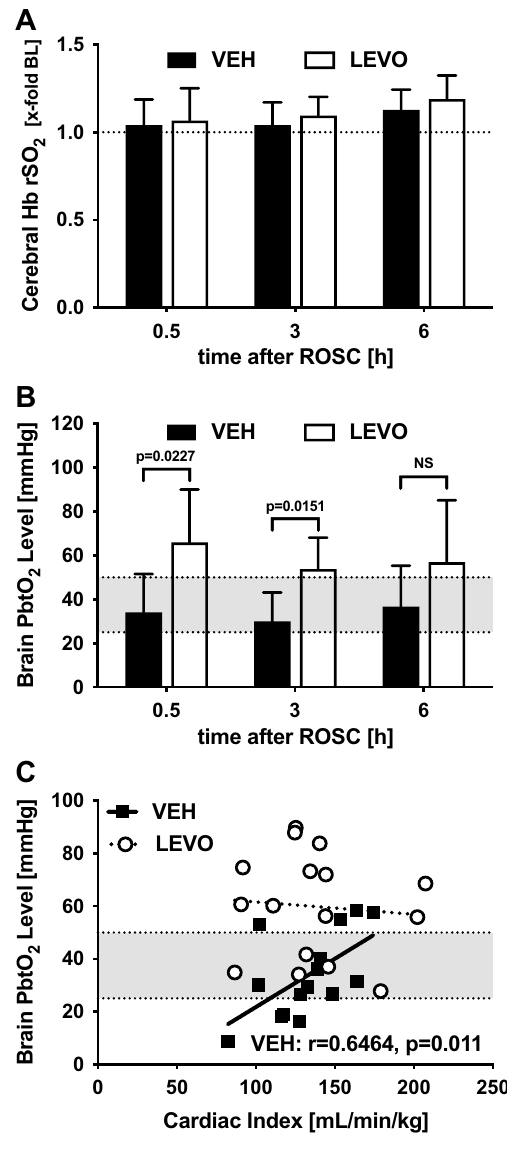
Figure 4. Cerebral tissue oxygenation. ( A ) Brain oxygenation was determined noninvasively by quantifying brain hemoglobin (Hb) oxygen saturation (rSO 2 ) before and 0.5, 3, and 6 h after ROSC. Because of high interindividual differences, readings were normalized to baseline. rSO 2 was not altered following cardiac arrest and did not differ between groups. VEH vehicle; LEVO levosimendan. Statistics: repeated measures two-way ANOVA, followed by Šidák’s multiple comparisons test; data are presented as means ± SD. ( B ) Brain tissue oxygen (PbtO 2 ) was measured using a Foxy probe 14 mm below the dura in the left hemisphere 0.5, 3, and 6 h after ROSC. Levosimendan-treated animals showed significantly higher PbtO 2 30 min and 3 h after ROSC. The normal PbtO 2 range (25–50 mmHg) is illustrated by the gray area. Statistics: Welch’s t test; data are presented as means ± SD. ( C ) Correlation analysis between PbtO 2 and cardiac index (CI) showed a significant association between cardiac function and PbtO 2 in vehicle-treated animals, whereas levosimendan-treated animals had normal PbtO 2 and showed no correlation between PbtO 2 and CI. The normal PbtO 2 range (25–50 mmHg) is illustrated by the gray area. Statistics: Spearman rank correlation